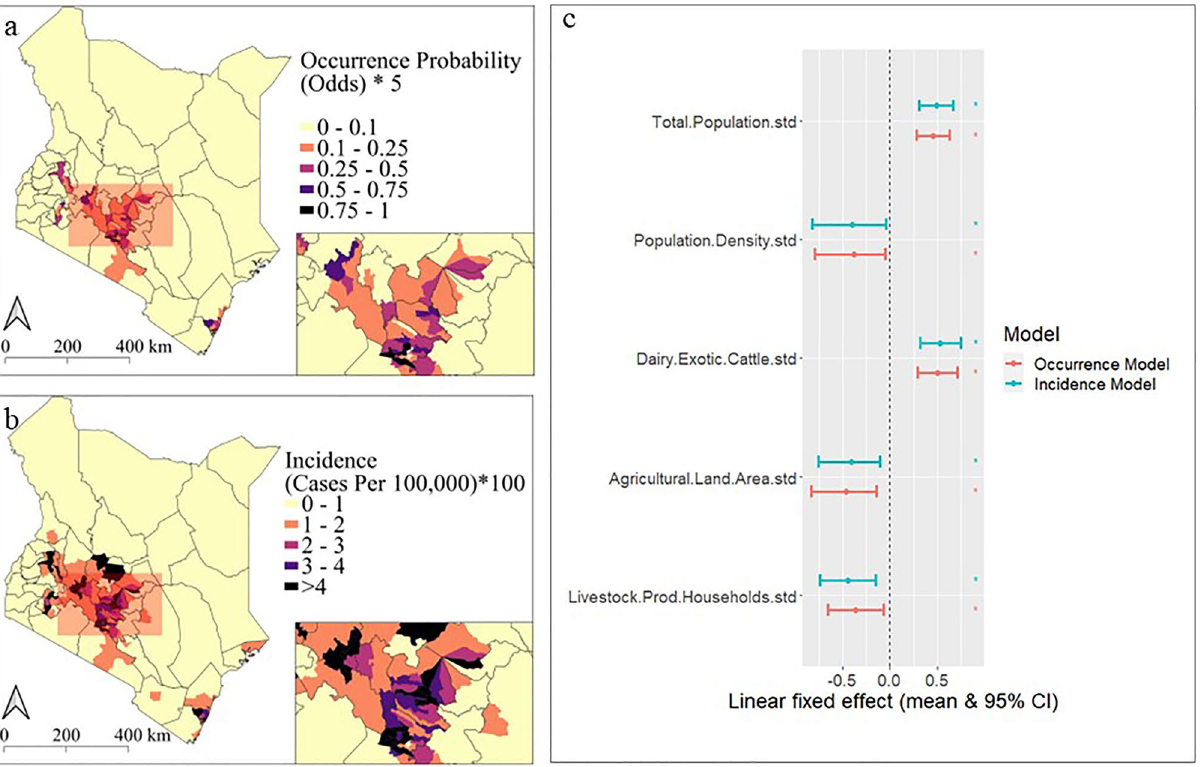
Figure 11. Spatial distribution and correlates of annual anthrax occurrence and incidence (2006–2020) at sub-county level across Kenya. Maps show the fitted probability of anthrax occurrence ( a ) and incidence ( b ; livestock cases per 100,000 people) for 290 sub-counties in the last quarter of 2020. The points and error bars ( c ) illustrate the parameter estimates of the linear socio-economic fixed-effects (the posterior mean estimate and the 95% credible interval) for the best-fitting models of anthrax occurrence (red) and incidence (blue) (n = 17,400 observations). The linear covariates were standardized (centered and scaled) before model fitting, such that parameters estimate the effect of 1 standard deviation change in the covariate on either the odds of occurrence or incidence. The models both included spatiotemporal random effects (sub-county per year) to incorporate spatial and temporal heterogeneity and were robust to geographical cross-validation tests (Fig. 10). Maps were generated using Quantum Geographical Information Systems (QGIS) v. 3.16.11 (https:// www. qgis. org/ en/ site/ forus ers/ downl oad. html).